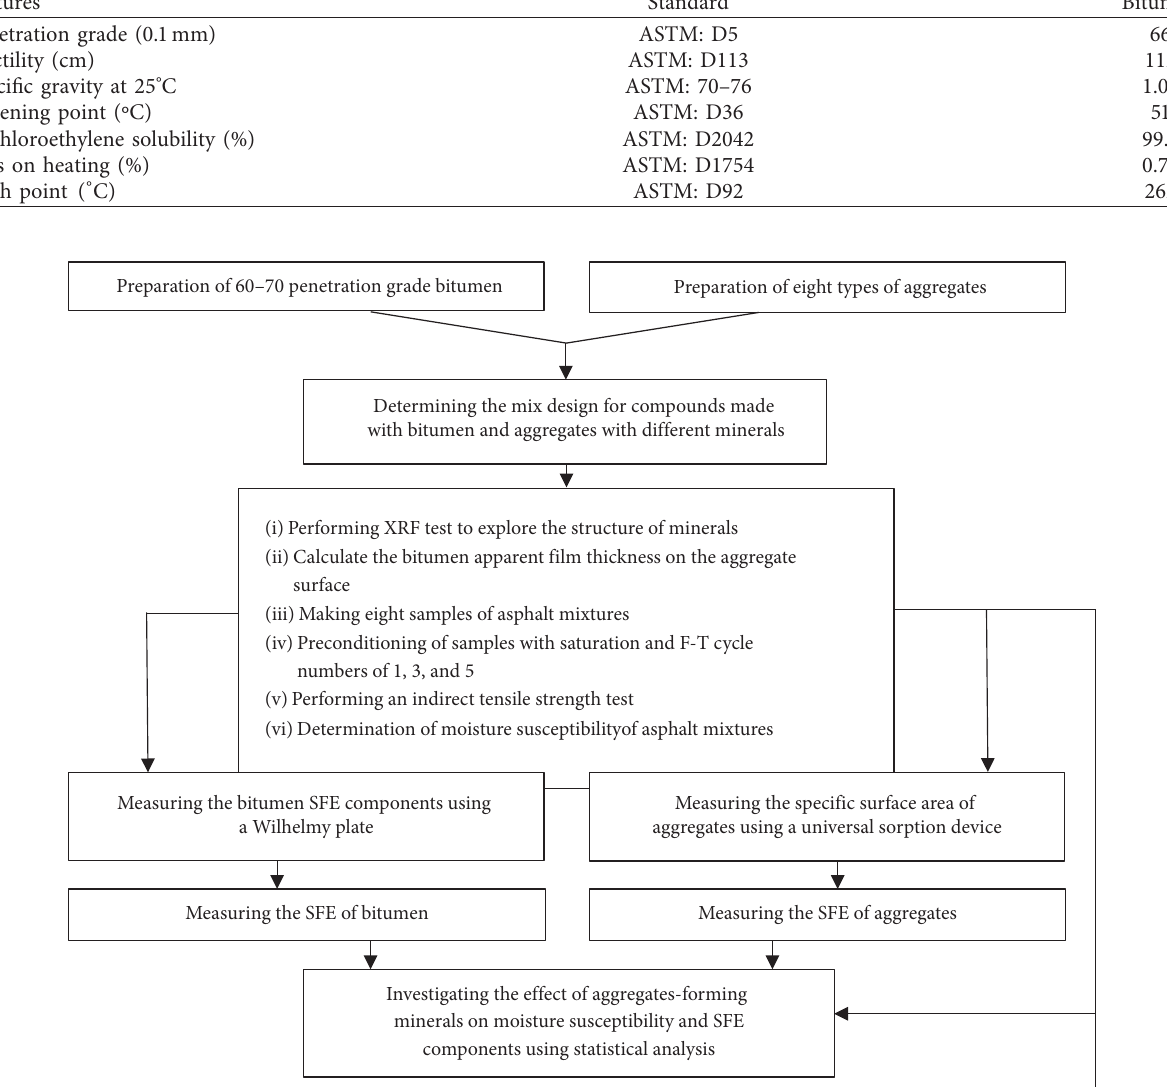
Figure 3: Testing plan of the present